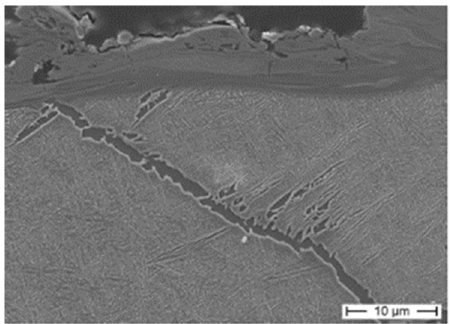
Figure 5. In situ specimen of a laser-cut EB-PBF-manufactured Ti-5553 alloy, SEM.